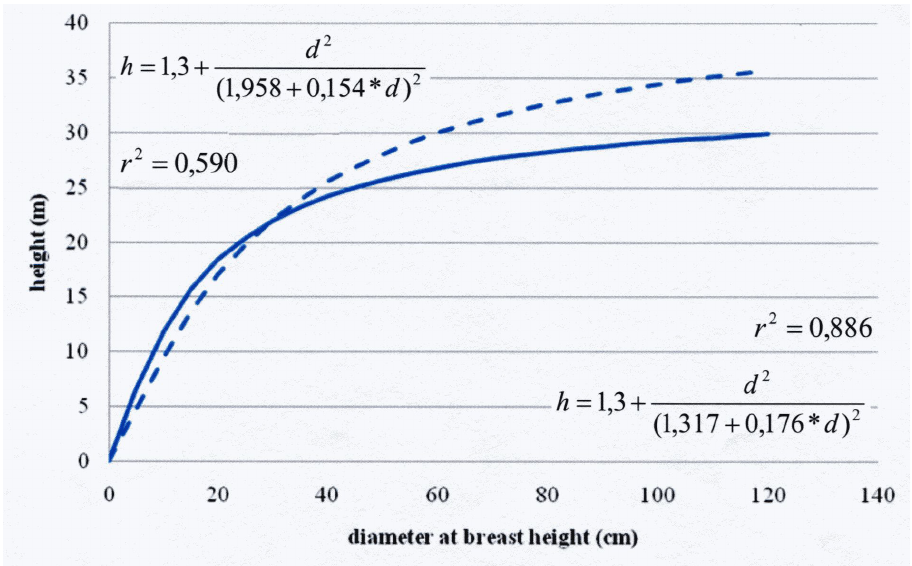
Figure 5. Naeslund height function for both study sites: Jeleni Bucina (solid line) and Bucina pod Fran- tiskovou Myslivnou (dashed line).